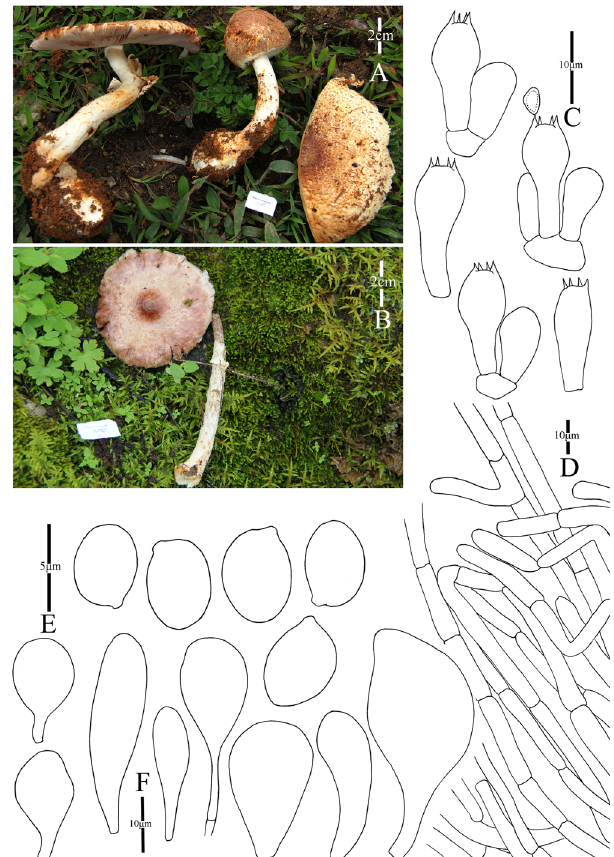
Figure 10. Morphology of Agaricus dilatostipes ( ZRL2014421 , holotype), ( A , B ): Basidiome in field ( A : ZRL2014421 ; ( B ): ZRL2014450 ), ( C ): Basidia, ( D ): Pileipellis hyphae, ( E ): Basidiospores, and ( F ):